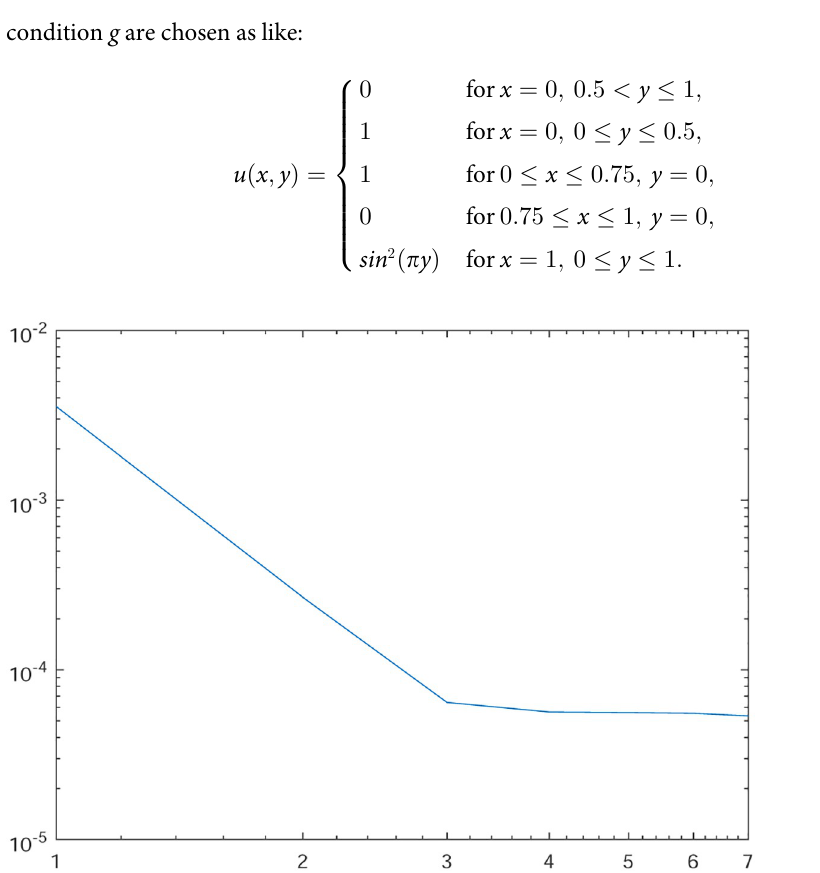
Fig 6. The behavior of the error with respect to the parameter γ for the Experiment